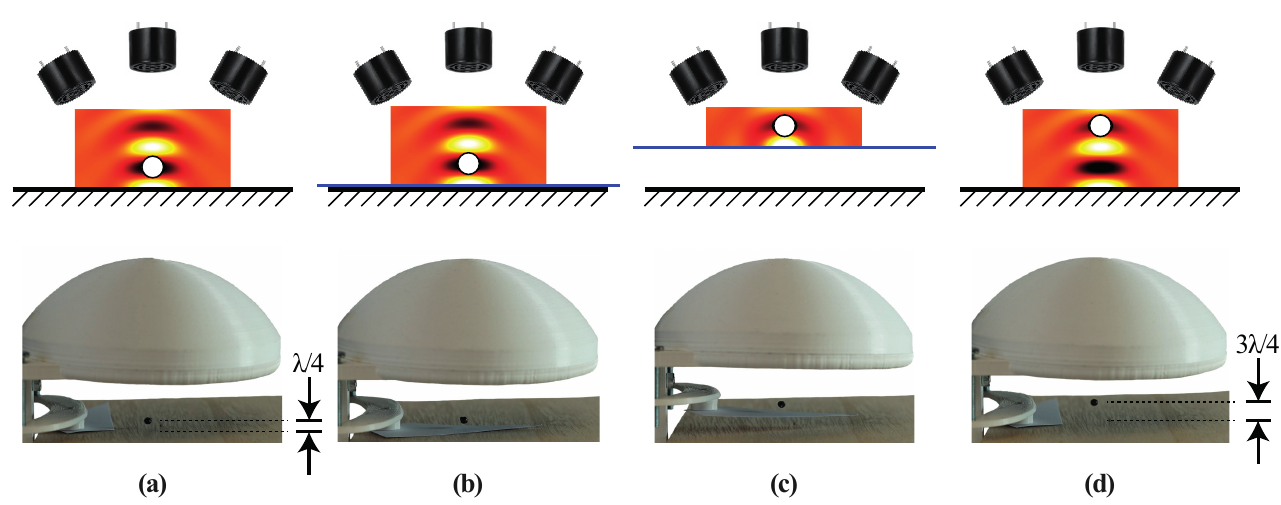
Figure 9. Process of lifting an object located at the lowest pressure minimum in a standing acoustic wave. ( a ) A standing wave between the transducer arrangement and an acoustically reflective surface is formed. The object is trapped in the lowest pressure minimum of the standing wave. ( b ) A thin reflector is inserted directly above the reflective surface. ( c ) The reflector is moved upwards until the levitating object reaches the levitation height of the second pressure minimum of the standing wave between the transducers and the reflective surface; ( d ) the reflector is removed and the object is located at the second pressure minimum. The shown elements correspond to those annotated in Figure